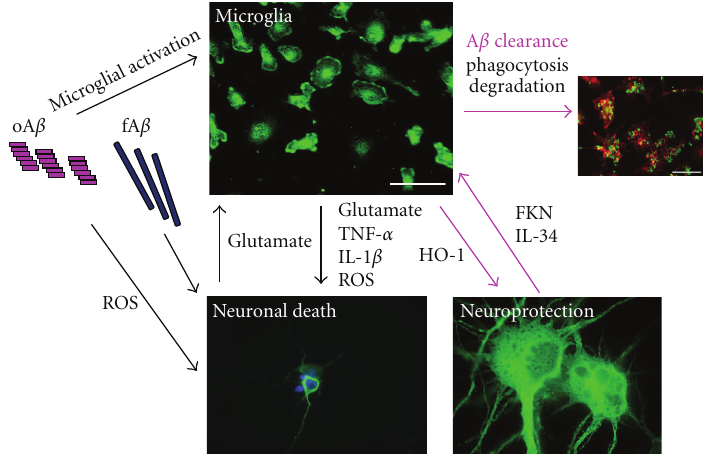
Figure 3: A β toxicity in neurons and microglia. A β is directly toxic to neurons by ROS, and enhances the production of microglia-derived neurotoxic molecules such as glutamate, TNF- α , and IL-1 β . Glutamate from degenerated neurons also induces microglial neurotoxicity. IL-34 and FKN induce microglial neuroprotection via A β clearance and antioxidant